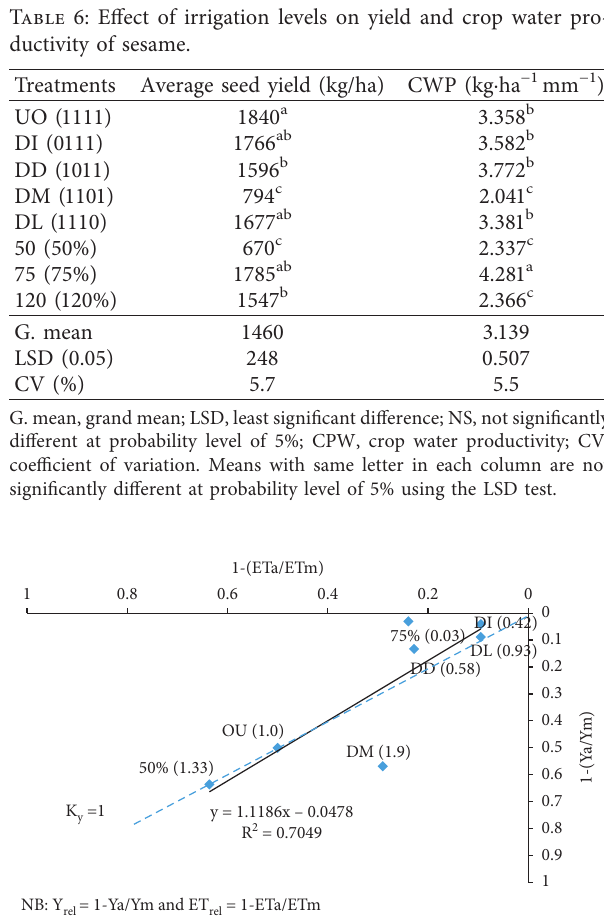
Figure 3: Relative sesame yield response to relative season water deficit.